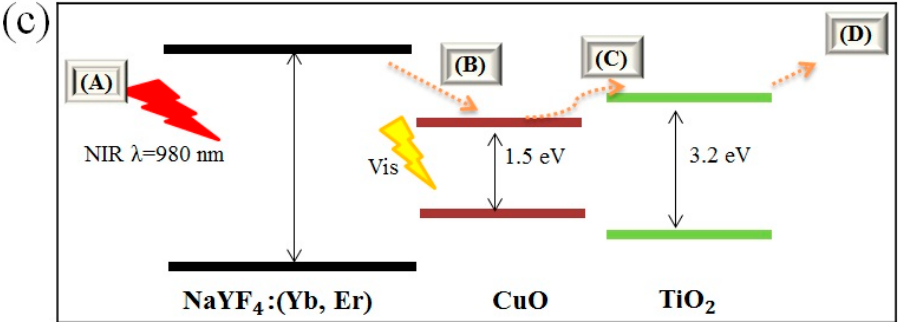
Figure 5. Photoluminescence spectra of ( a ) NaYF 4 :(Yb,Er), NaYF 4 :(Yb,Er)-CuO and NaYF 4 :(Yb,Er)- CuO/TiO 2 ; ( b ) enlargement spectra at 10 to 50 intensity axes and ( c ) schematic band structure and energy transfer routes in the NaYF 4 :(Yb,Er)-CuO/TiO 2 composites.